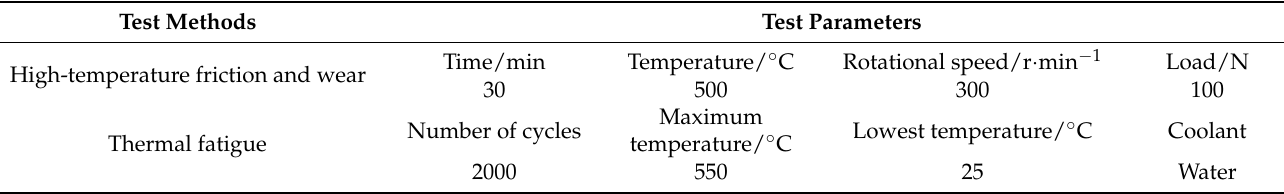
Figure 1. Specimen size: ( a ) high-temperature friction and wear; ( b ) tensile; ( c ) thermal fatigue. Table 3. Test parameters of high-temperature friction wear and thermal fatigue.